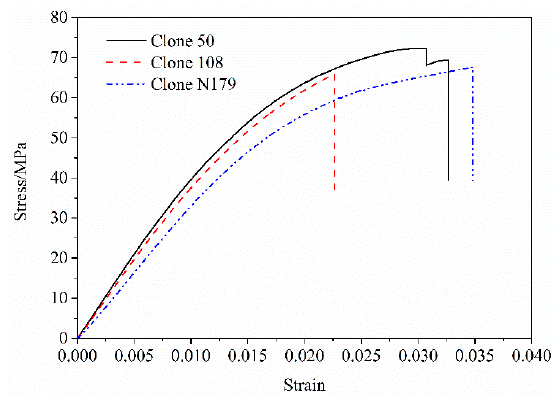
Figure 4. The stress–strain curves of MOR of three poplar